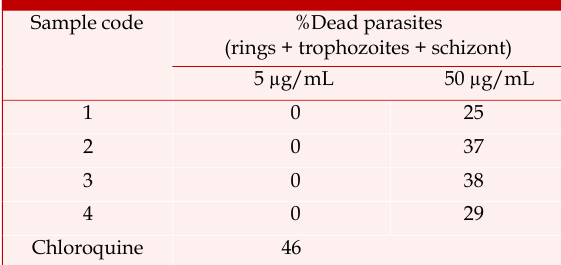
In vitro antimalarial assay of synthesized